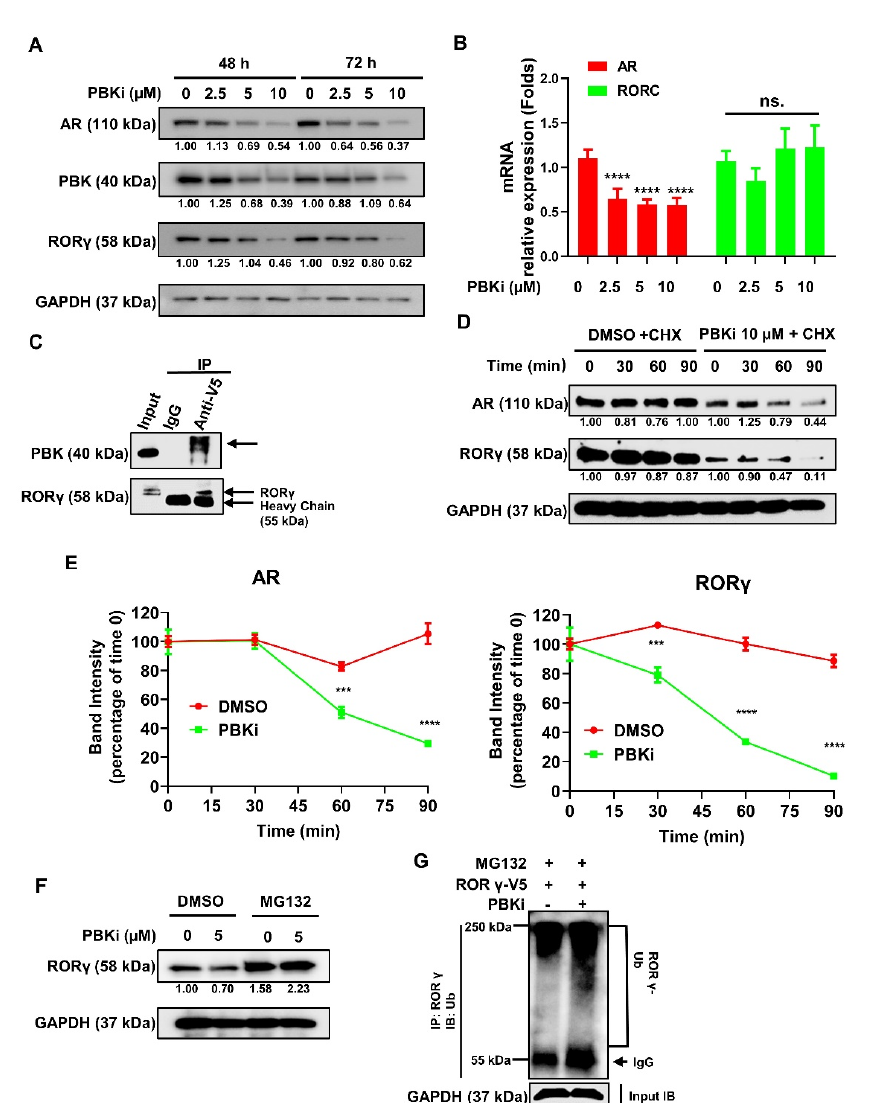
Figure 5. PBK interacts with ROR γ and regulates its stability in CRPC cells. ( A ) Western blotting analysis of C4 − 2B cells treated with indicated concentrations of PBKi for 48 h and 72 h. ( B ) qRT − PCR analysis of AR and RORC mRNAs in C4-2B cells treated for 72 h treatment with PBKi. ( C ) co − IP analysis of C4 − 2B cells expressing V5 − ROR γ . Cell lysates were first pulled down by anti − V5 or control IgG antibody. The co − IPed complexes were then subject to western blotting with anti − PBK or ROR γ antibody. ( D ) Western blotting of C4-2B cells incubated with 5 μ M PBKi for 48 h and then treated with 50 μ M CHX for indicated times. ( E ) The band intensity of each treatment as in D was analyzed using ImagJ and normalized to GAPDH. The percentage of band intensity was calculated by referring to time 0. ( F ) Western blotting of V5 − ROR γ − expressing C4-2B cells first treated with 5 µ M PBKi for 48 h and then treated with 10 µ M MG132 for 3 h. ( G ) ROR γ protein was first pulled down by ROR γ antibody and then ubiquitin levels of ROR γ in the complexes were detected by anti-ubiquitin antibody. Density of bands was measured and presented as in Figure 1. Results are presented as mean ± SD. *** p < 0.001, **** p <